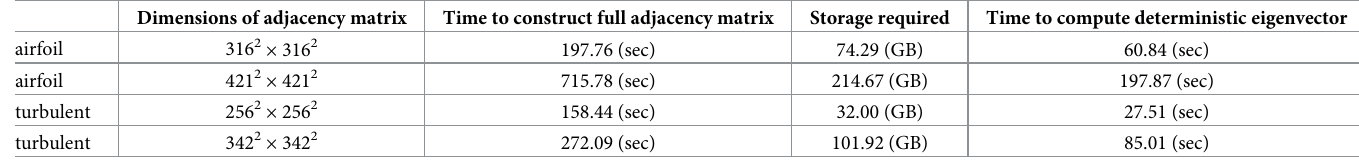
Table 1. Summary of computational results for constructing the full adjacency matrix and computing the dominant eigenvector using the deterministic power method. Here the computational bottleneck is the memory required to construct the adjacency matrix. Note that the power method does not generally require that the full adjacency matrix is constructed explicitly; however, the power method is not efficient because the adjacency matrices we consider are dense.